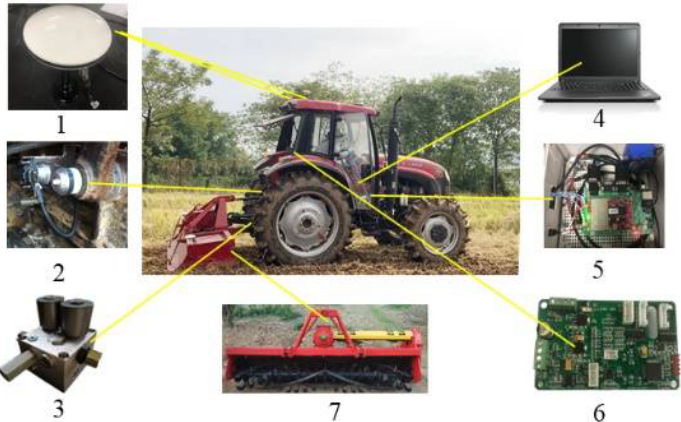
Figure 1. Components of the tillage depth control system for the tractor-rotary tiller stubble burying system. (1) RTK-GNSS receiver antenna. (2) Electronic-control proportional hydraulic valve. (3) Angle sensor. (4) On-board computer. (5) RTK-GNSS rover station. (6) STM32 microcontroller. (7) Rotary tiller for stubble burying.